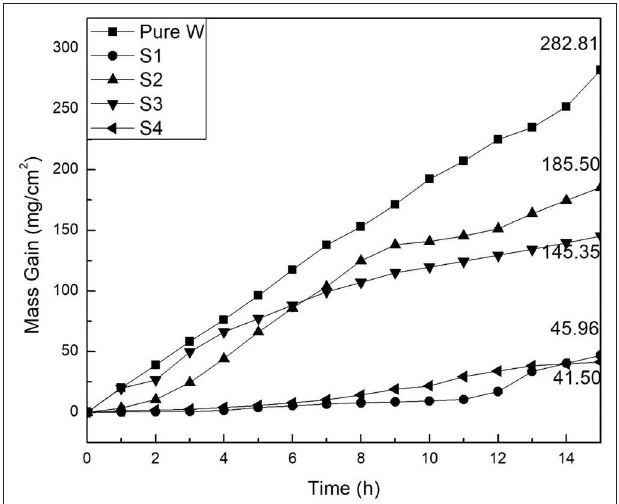
FIGURE 6 | Mass change of the coated and uncoated samples after 15h at T = 1,000 ◦ C.